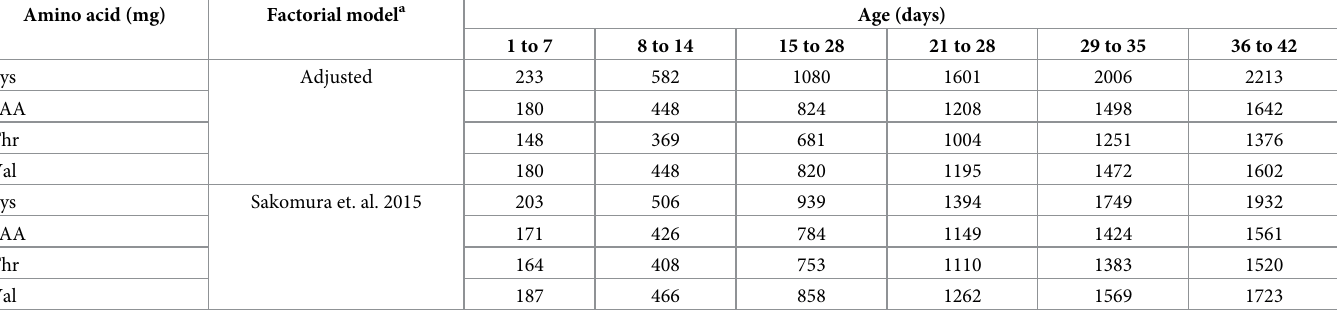
Table 6. Lysine (Lys), sulfur-amino acid (SAA), threonine (Thr), and valine (Val) requirement for broiler chickens (mg/bird/day), determined by factorial approach using distinct efficiencies of utilization ( EU ) for feather-free body and feather, or same value for both parts. Amino acid